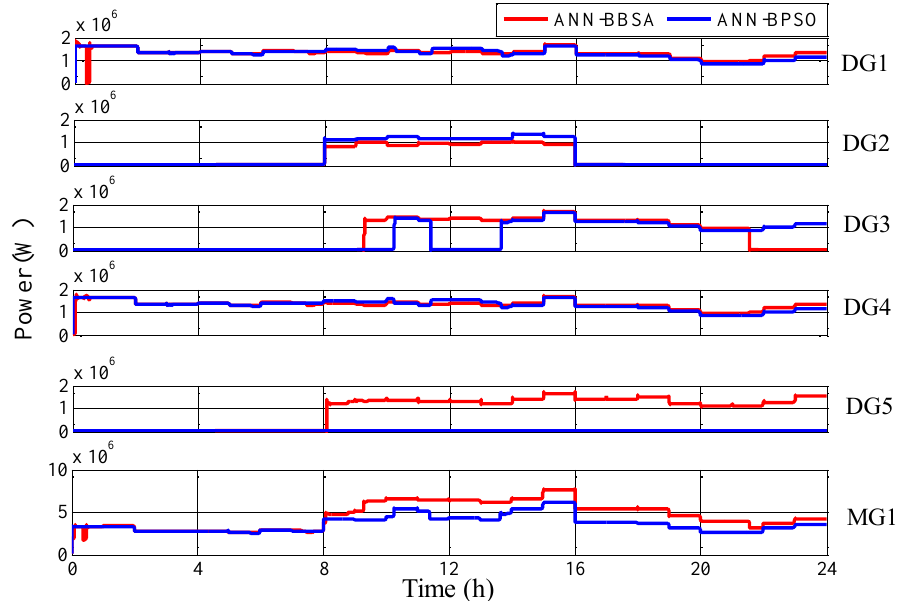
Figure 11. Test 1 testing data results using ANN-BBSA and ANN-BPSO in the microgrid at bus 5.